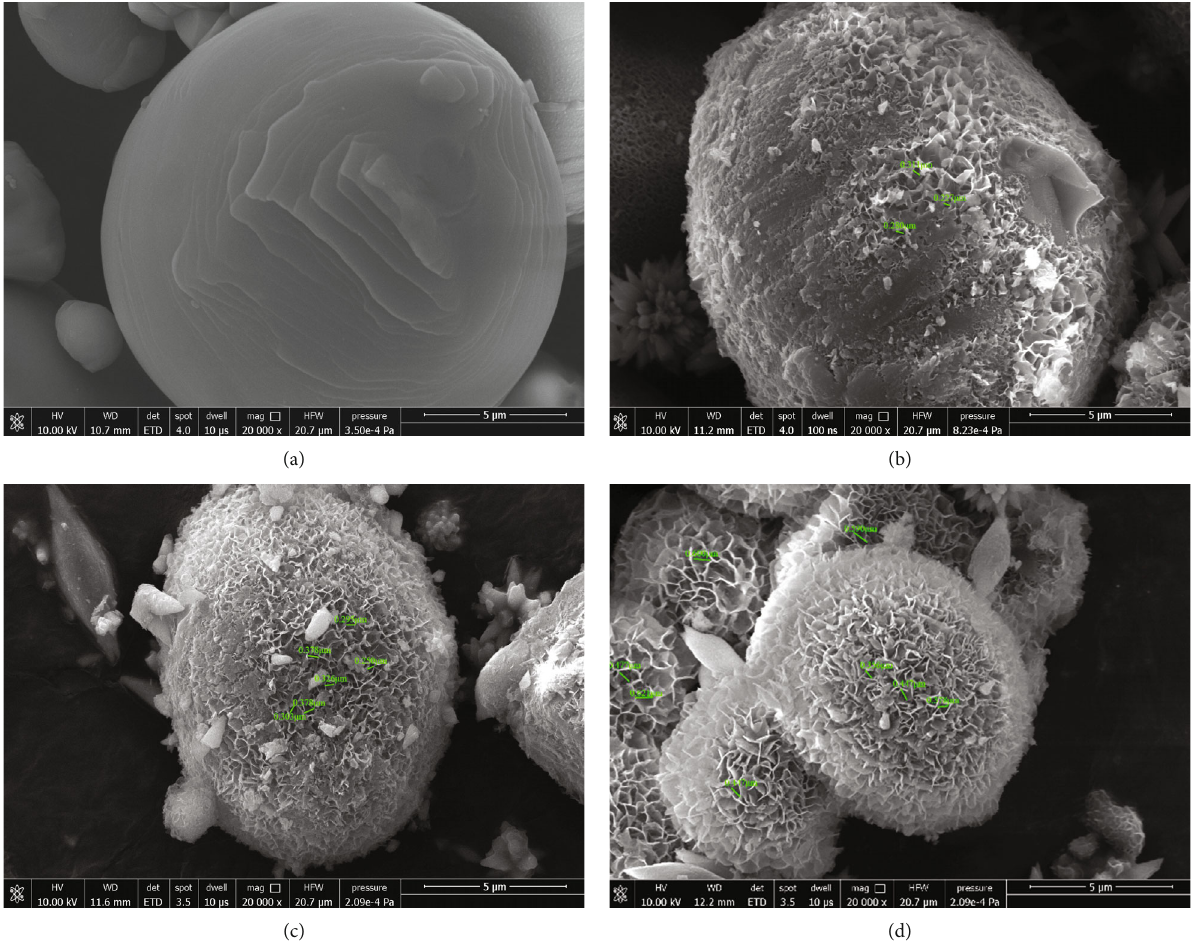
Figure 6: (a) Magnesium hydride. (b) Hydrolyzed product without surfactants. (c) MgH MgH :TPABr =1: 1, hydrolyzed product ( × 2